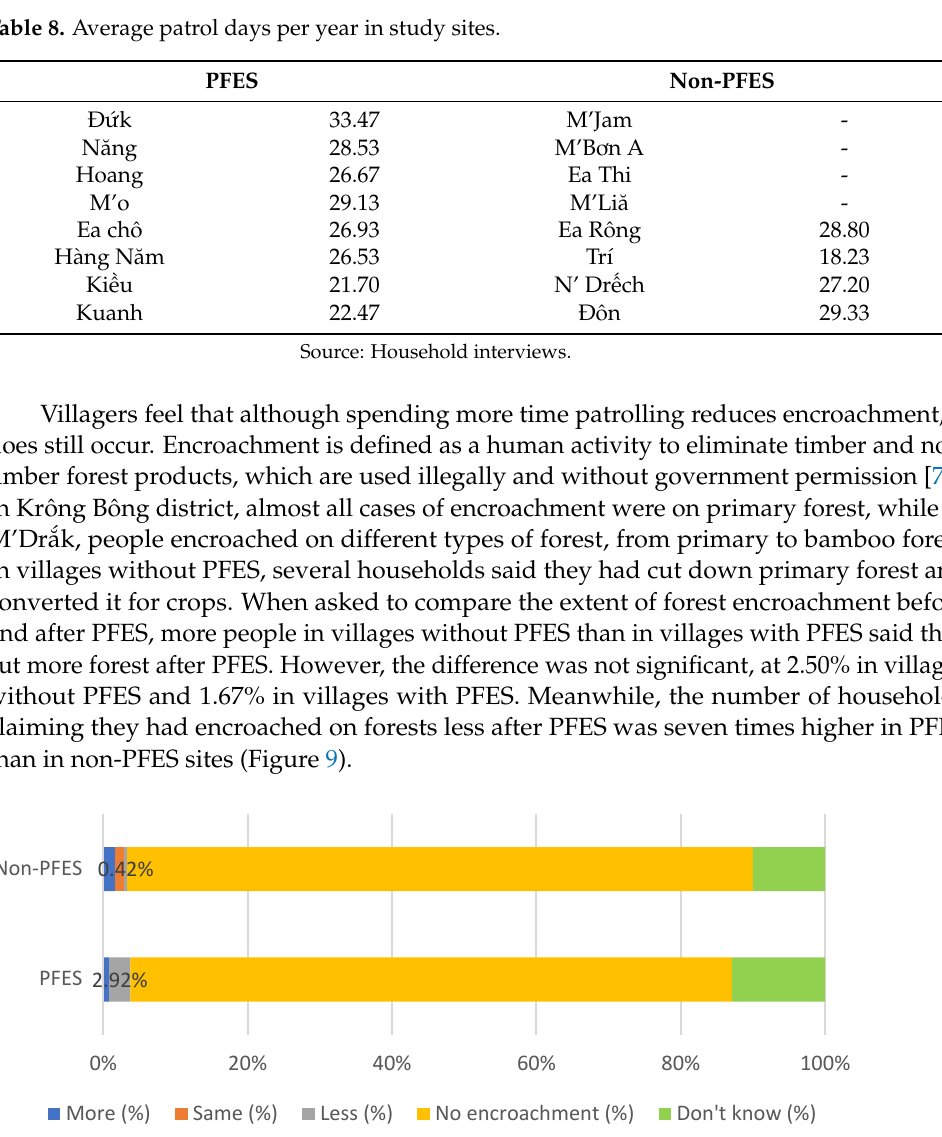
Figure 10. Ownership of encroached forest. Most interviewed government officials said people encroaching on forests to collect non-timber forest products (NTFPs), such as mushrooms and bamboo shoots for their daily needs and to sell to local markets for additional income, put high pressure on forests in both PFES and non-PFES sites, but due to strengthened law enforcement in PFES sites, encroachment on natural forest is lower than in non-PFES sites where people are not of- fered PFES payments. Local stakeholders also identified several issues currently limiting the policy. First, service providers are paid to conduct patrols and take other measures to protect the forest, but community-led patrolling is challenging. The payments people receive are deemed too low for the time and effort they expend traversing harsh craggy mountains. Villagers are not properly equipped with uniforms, personal protective equipment or other facilities. Crucially, they have no power to address any violations they encounter. Violators are increasingly aggressive and better equipped, while community patrol teams are unable to impose fines and lack the means to protect themselves. Other issues are the different payment rates applied for different watersheds (Table 3) creating a sense of in-